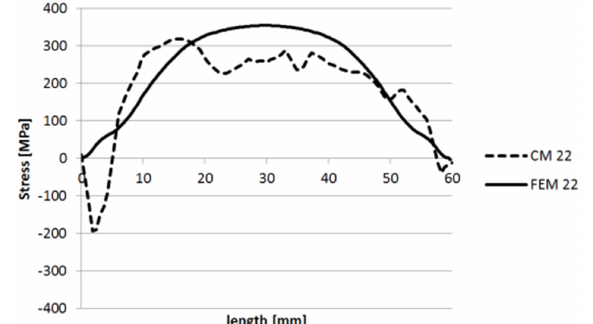
Figure 48. Stress levels in 22 direction along the AB line segment.